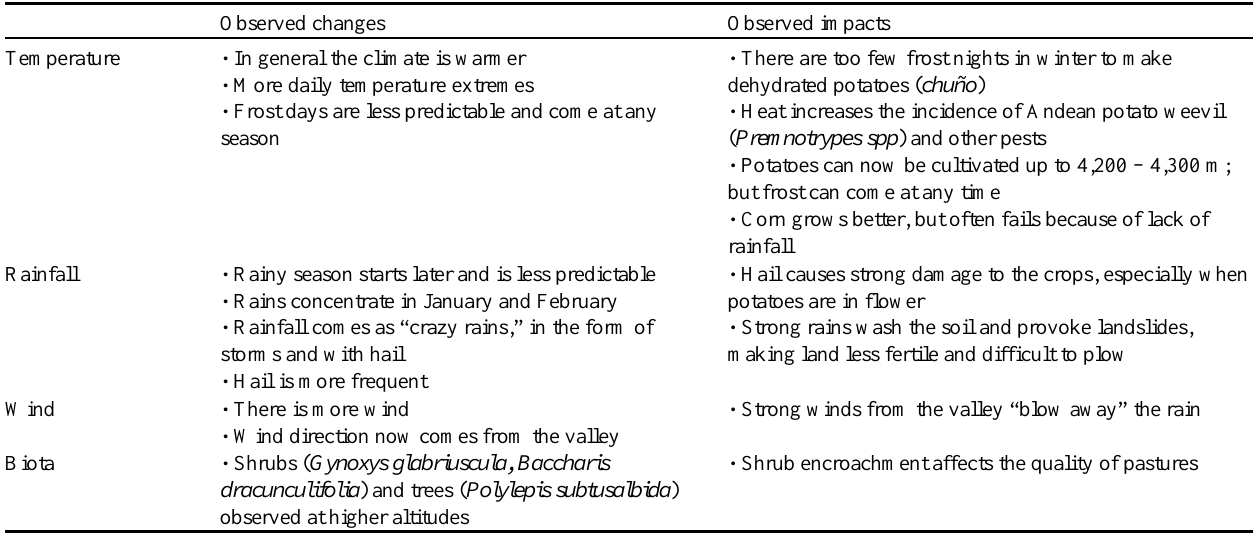
Table 1 . Observed weather changes and their impact in